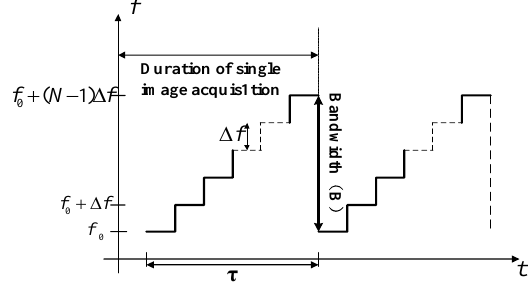
Figure 1. SFCW time-frequency domain change